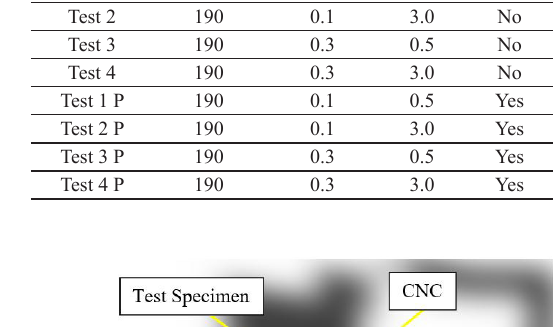
Table 2. Cutting tests and number of tests. Test/Test Parameter